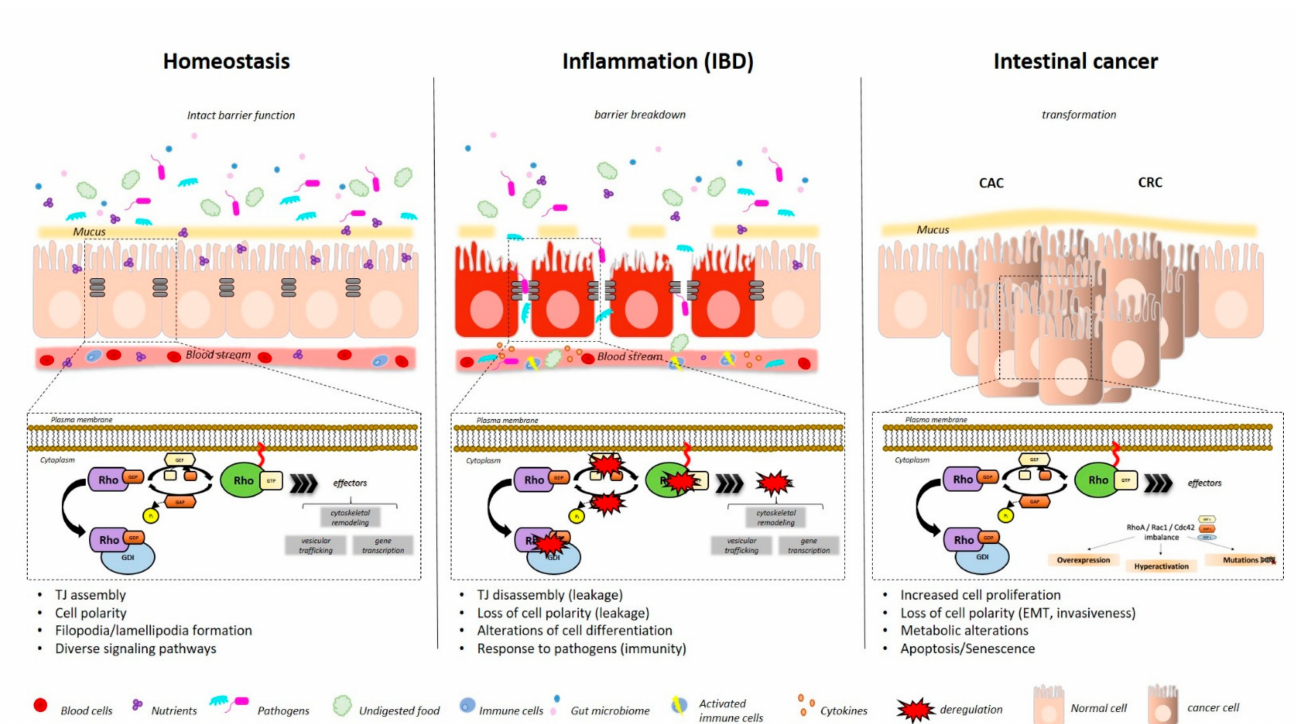
Figure 2. Alterations of small GTPases function within Intestinal epithelium in the context of Intestinal Bowel Disease (IBD) and Colorectal Cancer